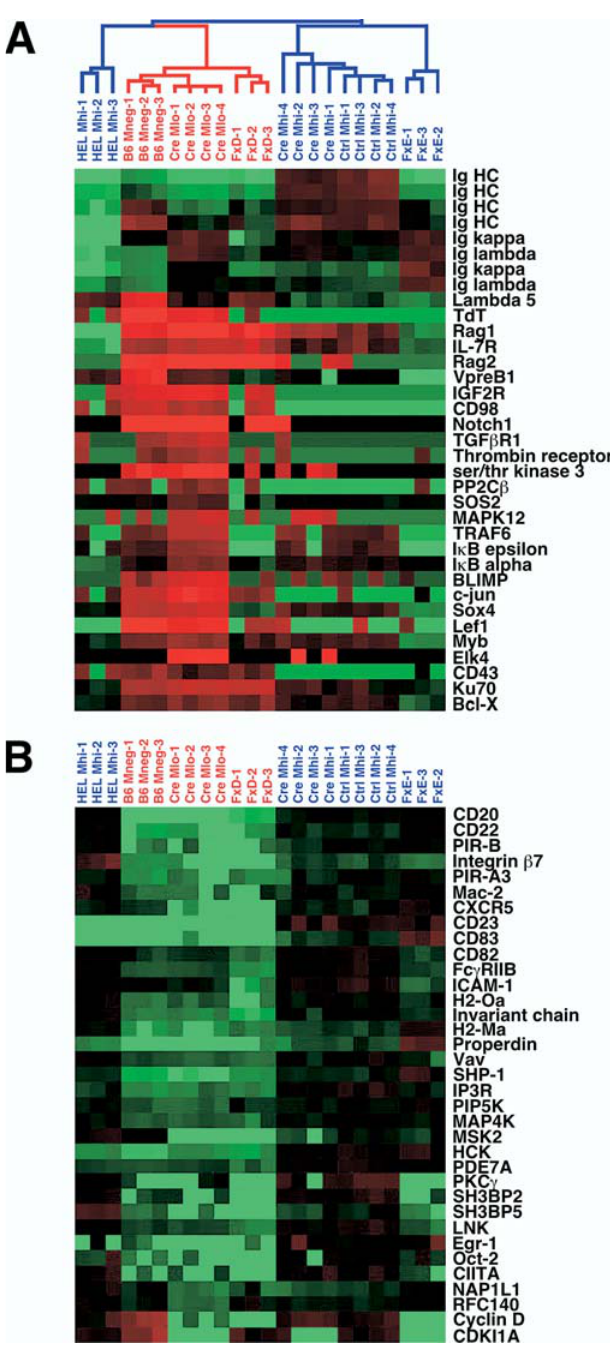
Figure 3. Genes Differentially Expressed between Ctrl-M hi and Cre-M lo Cell Populations Shown are representative genes that were generally either (A) up- regulated or (B) down-regulated in Cre-M lo cells compared with Ctrl-M hi cells. See Figure 2 legend for details. DOI: 10.1371/journal.pbio.0030082.g003